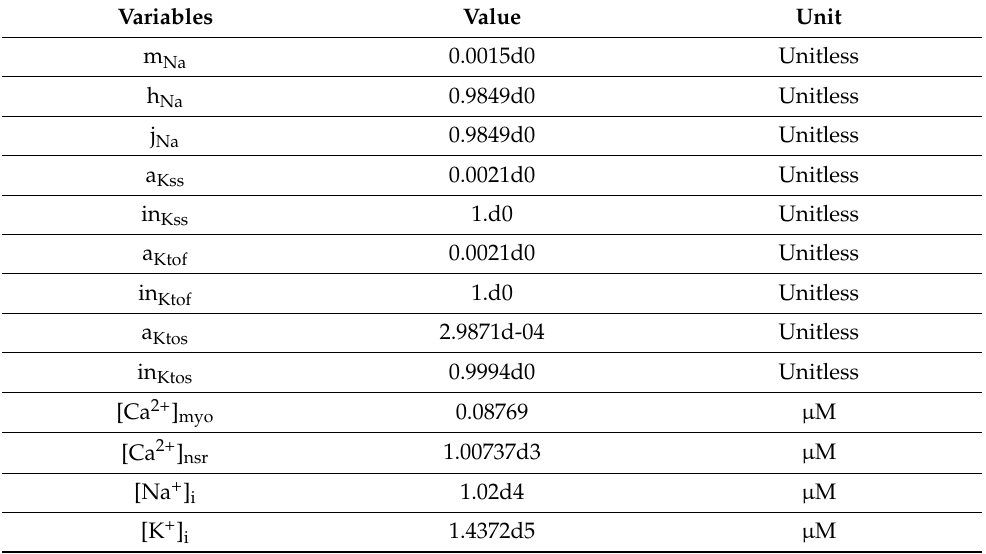
Table A2. Initial